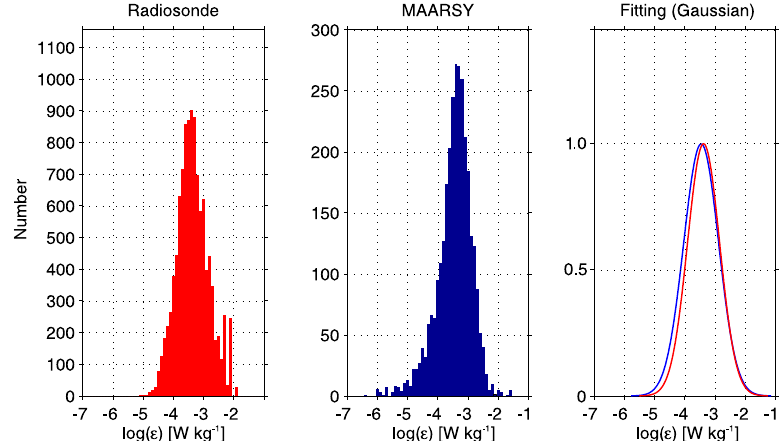
Figure 7. Histograms of the derived dissipation rates from radiosondes (left panel) and radar (middle panel) based on the simultaneous mea- surements during the WADIS campaign in 2013. All turbulent layers, including both significant and non-significant ones, from radiosondes are taken into account. In order to compare the ε distribution from both instruments, we fit the ε histograms with a Gaussian function, and the normalized fitting lines are shown in the right panel.